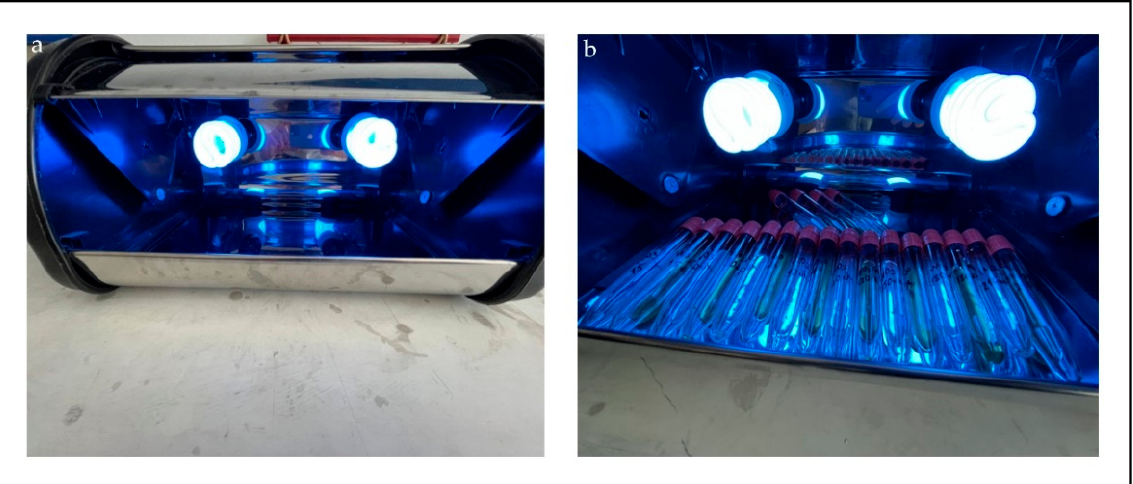
Figure 1. Designed UV cabinet ( a ); ( b ) tubes prepared for measurements to be made with different time